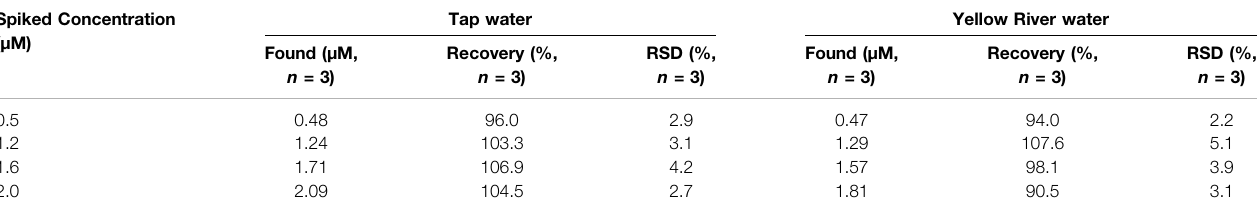
TABLE 2 | The rate of recovery of Hg 2+ in water samples (Using luminescence spectrometer). Spiked Concentration ( μ M)